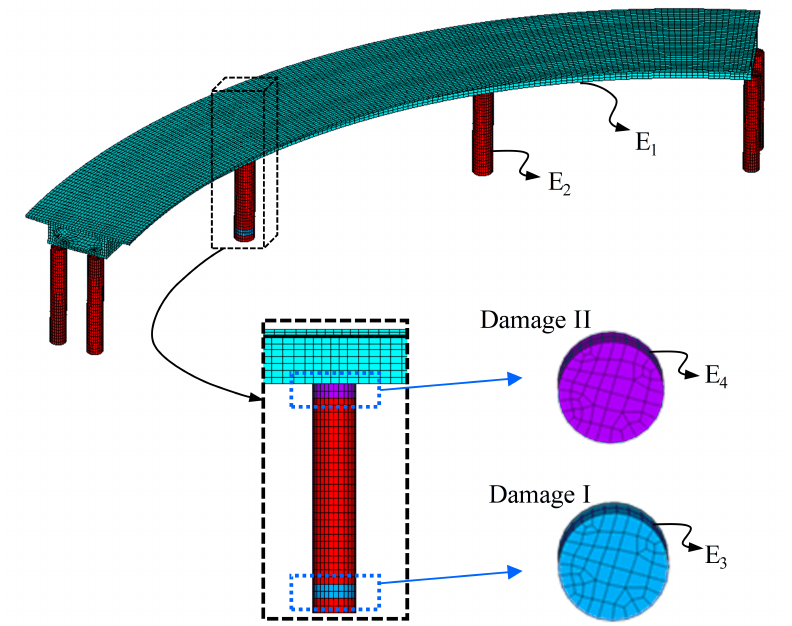
Figure 3. FE model of the investigated CCGB with zoomed-in Damage I and II ( E 3 , E 4 < E 2 ).